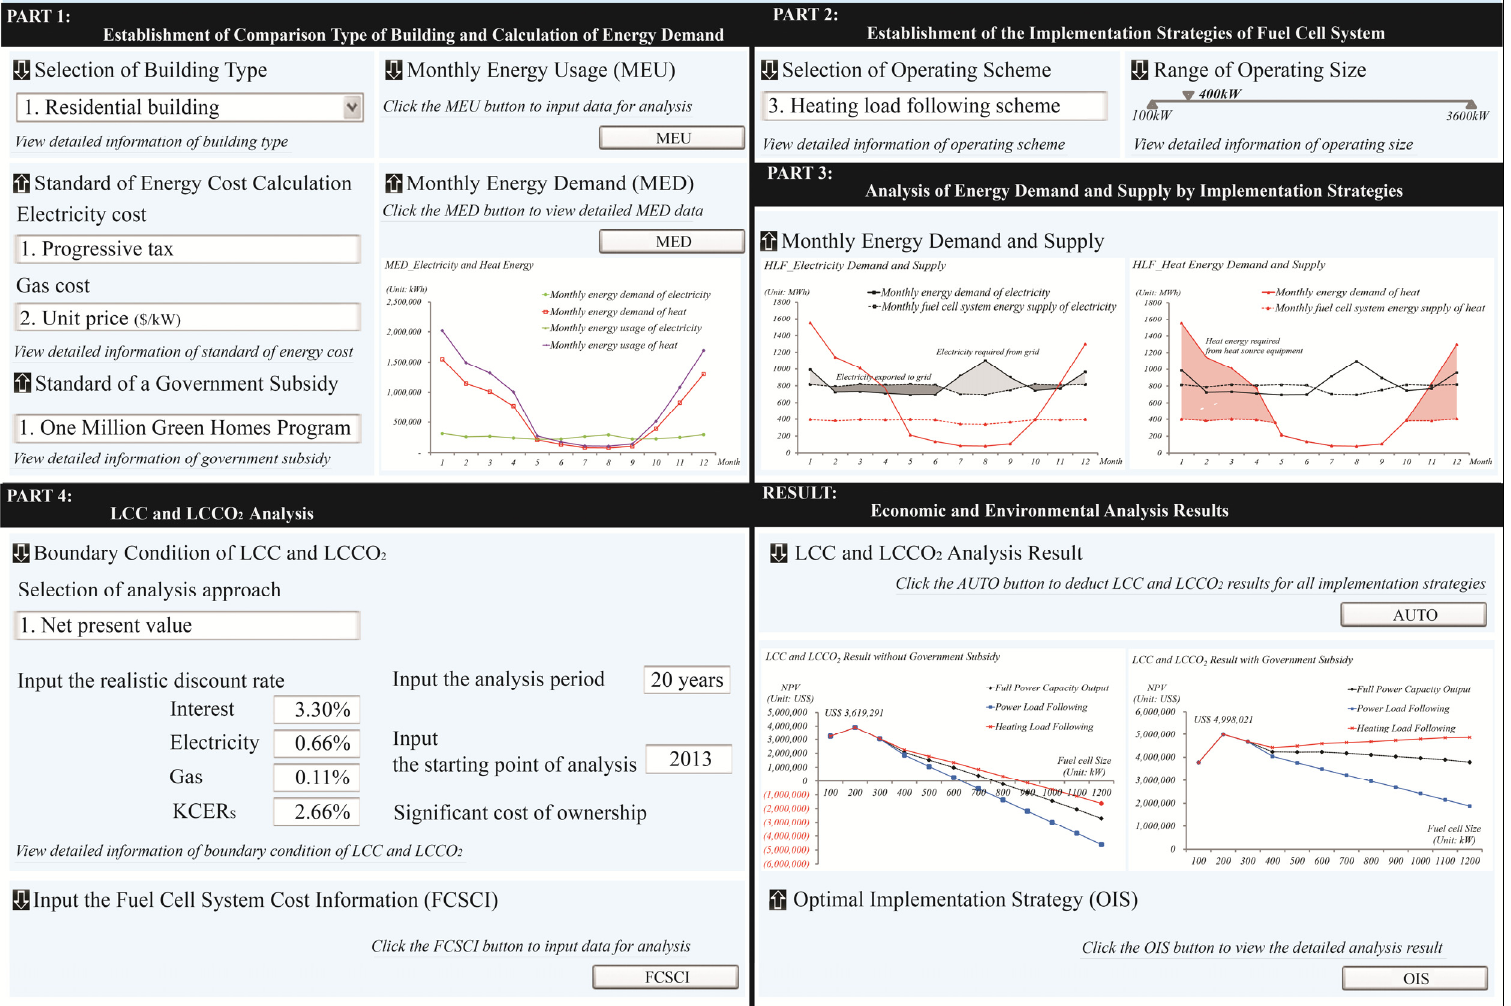
Figure 5. Graphical user interface of the developed